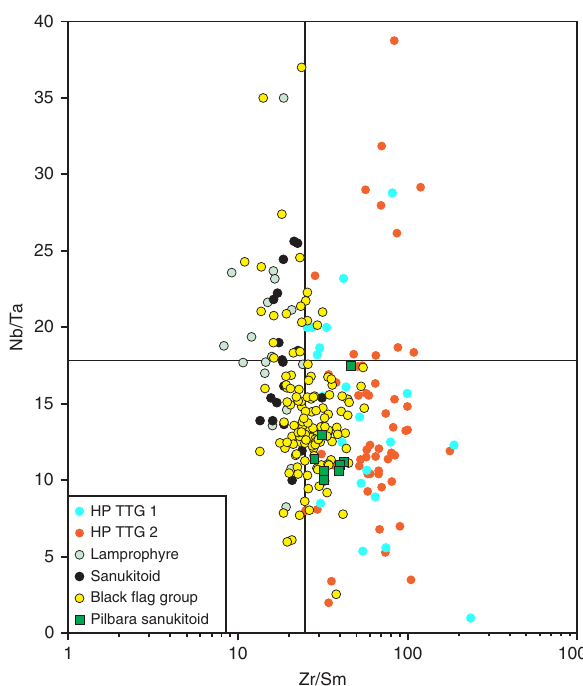
Fig. 7 Plot of Nb/Ta against Zr/Sm comparing data from the Black Flag Group, and associated rocks, with high-pressure TTG. When plotted on a Nb/Ta vs. Zr/Sm 35 diagram, TTG show a wide scatter at typically low Nb/Ta and high/Zr ratios. Lamprophyres, intrusive sanukitoids and volcanic rocks of the Black Flag Group show a trend with increasing compositional evolution, towards the fi eld of high-pressure (HP) TTG. Sanukitoids from the Pilbara Craton 27 are also plotted for comparison.